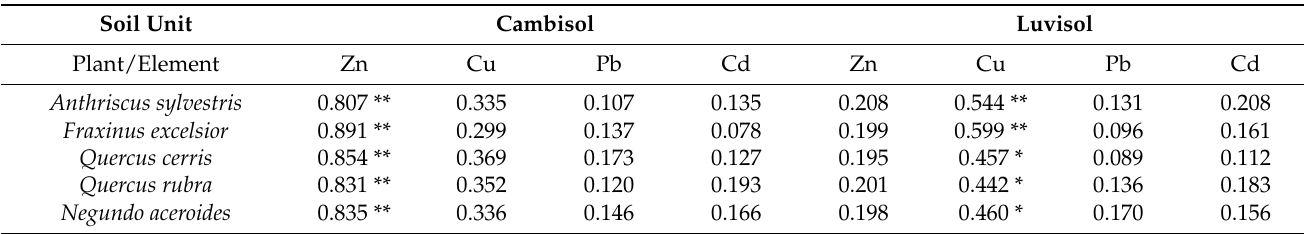
Table 6. Pearson’s correlation coefficients (r) between trace elements in soils and plants ( n = 12). * p < 0.05; ** p <